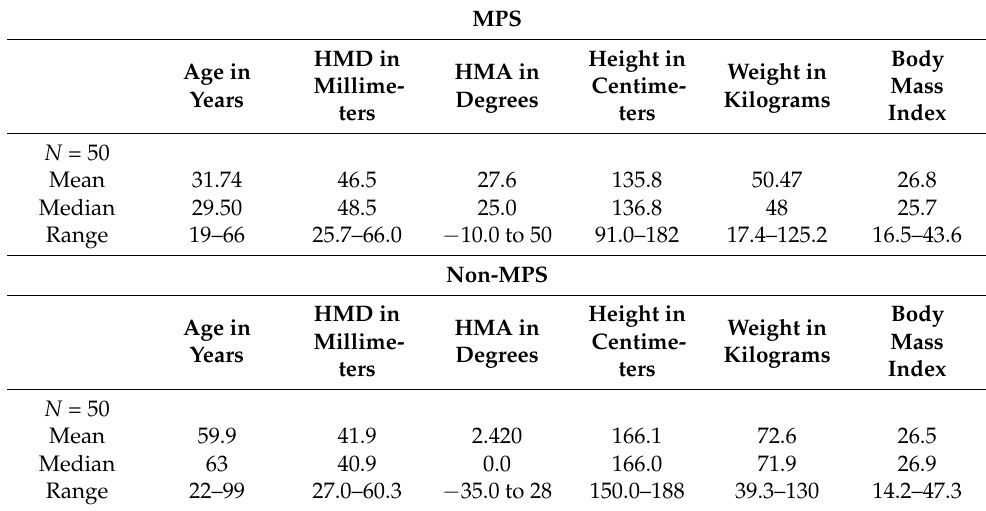
Table 4. HMD and HMA in the MPS and non-MPS groups.